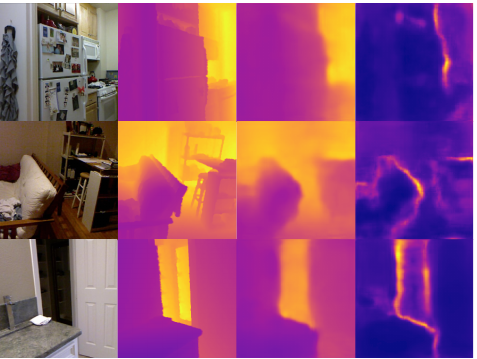
Figure 7. Some result visualizations of dense depth and depth uncertainty predictions on NYU Depth V2 dataset in RGB modality. From left to right column: input RGB images, dense depth ground truth, and predictions of dense depth and depth uncertainty maps.